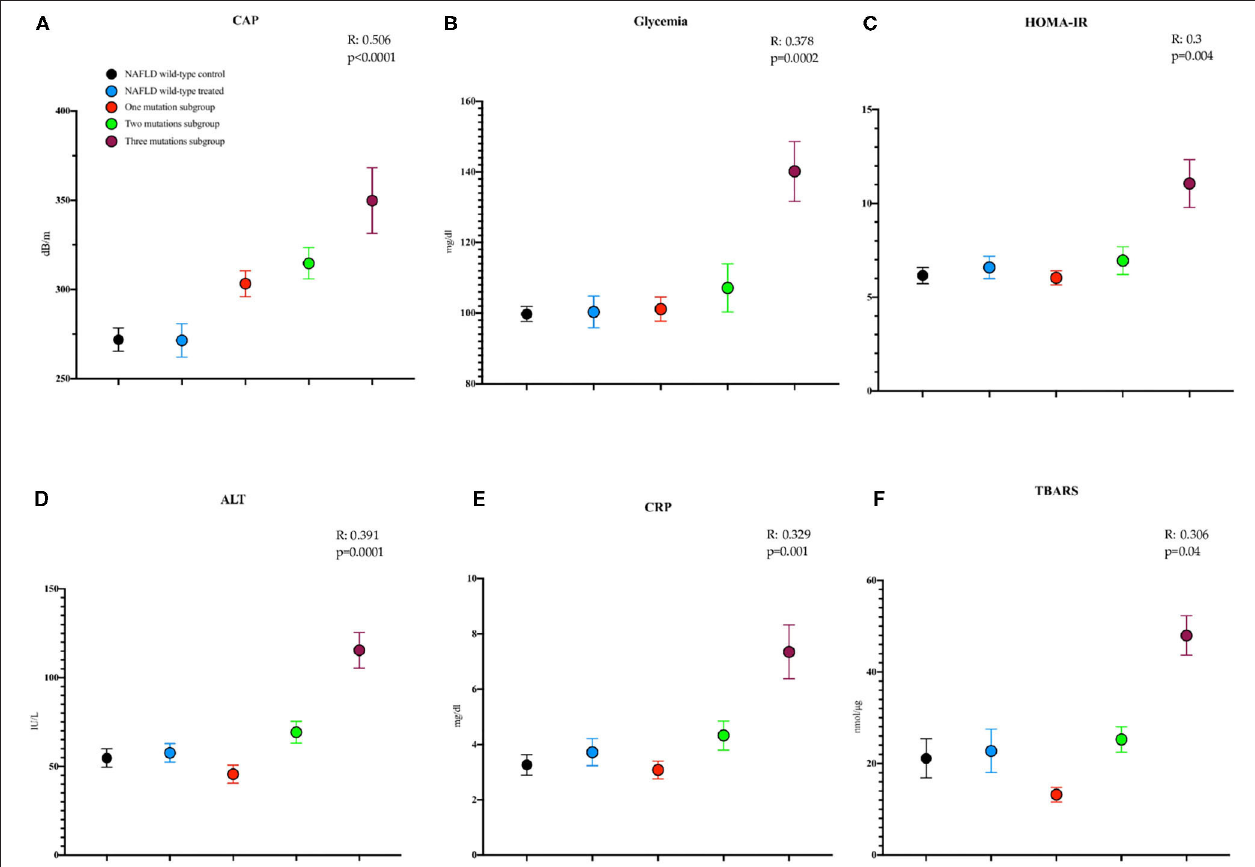
FIGURE 2 | Mean with SEM values of some study parameters showing, at the linear regression model applied, a direct worsening relationship with the number of mutations at baseline. (A) Controlled attenuation parameter (CAP) (NAFLD wild type control: T0: 271.9 ± 6.5; NAFLD wild type treated: T0: 271.5 ± 9.4; one mutation subgroup: T0: 303.3 ± 7.3; two mutations subgroup: T0: 314.7 ± 8.7; three mutations subgroup: T0: 349.8 ± 18.5 dB/m). (B) Glycemia (NAFLD wild type control: T0: 99.7 ± 2.1; NAFLD wild type treated: T0: 100.3 ± 4.5; one mutation subgroup: T0: 101.2 ± 3.4; two mutations subgroup: T0: 107.2 ± 6.8; three mutations subgroup: T0: 140.2 ± 8.5, mg/dl). (C) The homeostatic model assessment for insulin resistance (HOMA-IR) (NAFLD wild type control: T0: 6.15 ± 0.4; NAFLD wild-type treated: T0: 6.59 ± 0.59; one mutation subgroup: T0: 6.03 ± 0.37; two mutations subgroup: T0: 6.95 ± 0.73; three mutations subgroup: T0: 11.06 ± 1.28). (D) Alanine aminotransferase (ALT) (NAFLD wild-type control: T0: 54 ± 5.2; NAFLD wild-type treated: T0: 57 ± 5.1; one mutation subgroup: T0: 45 ± 5.1; two mutations subgroup: T0: 69 ± 6.1; three mutations subgroup: T0: 115 ± 10 IU/L). (E) C reactive protein (CRP) (NAFLD wild type control: T0: 3.26 ± 0.37; NAFLD